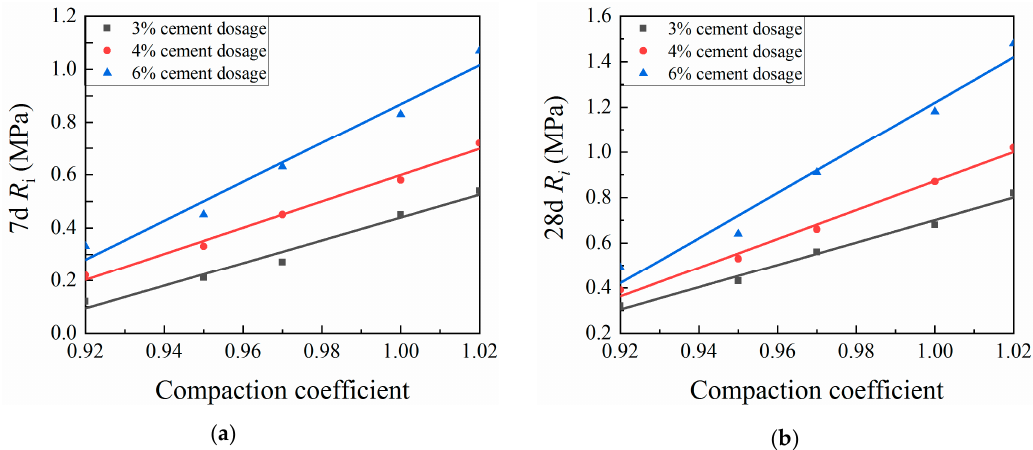
Figure 9. Relationship between compaction coefficient and splitting strength (SS) of cement-modified loess (CML): ( a ) seven-day (7d) SS; and ( b ) twenty-eight-day (28d) SS.